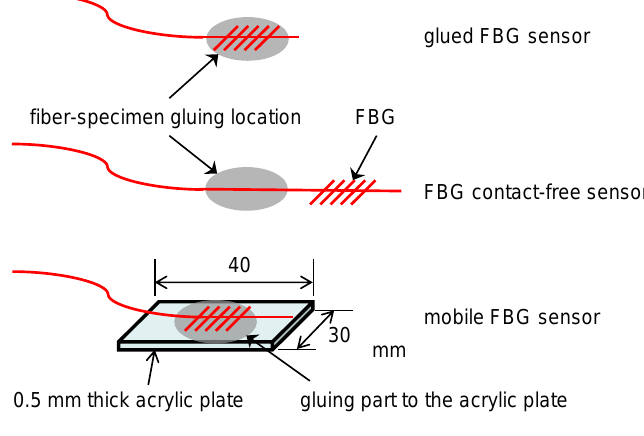
Figure 3. Schematics illustrating the configurations of FBG sensors employed in the present study.